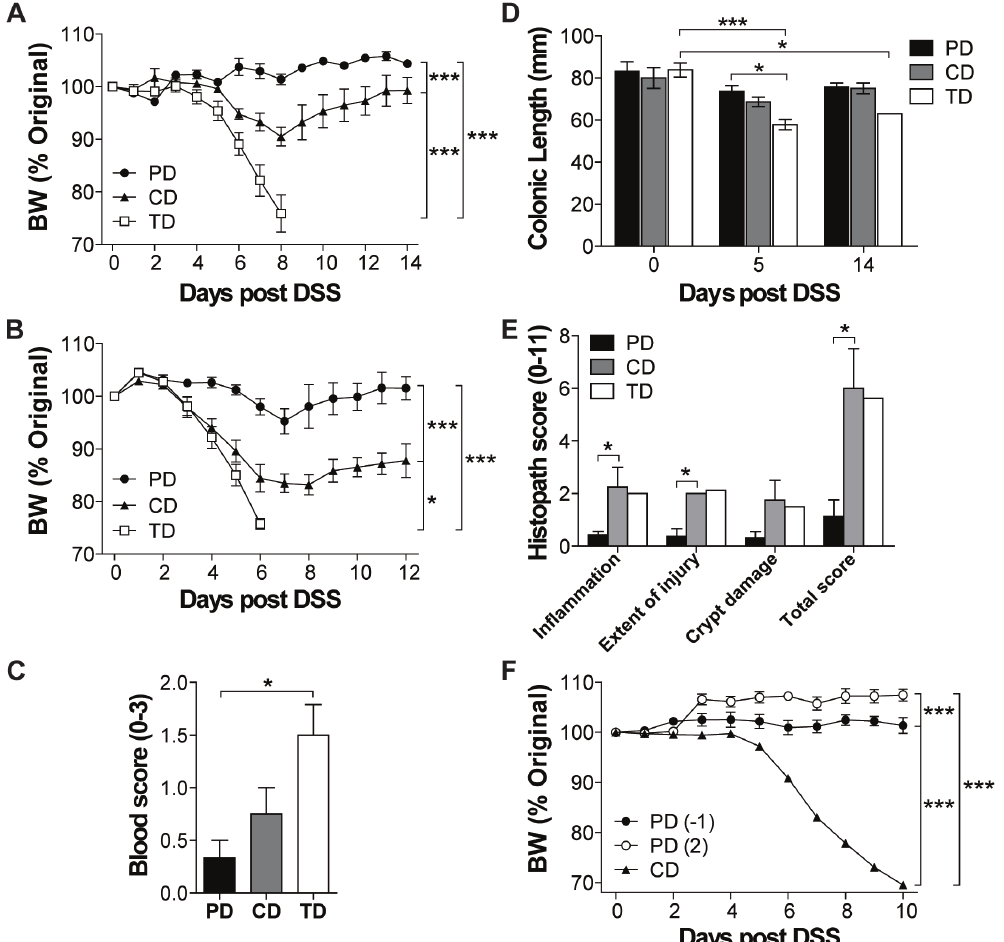
Figure 1. Diet induced changes in the susceptibility to DSS. WT or Rag KO mice were fed the experimental diets for 2 wks prior to 2.5% DSS treatment and throughout the experiment. Percent original BW of (A) WT (n=4–6 mice/group) and (B) Rag KO mice following the start of DSS treatment (n=3–5 mice/group). All three dietary groups were significantly different from each other (*P , 0.05, ***P , 0.001, two-way ANOVA). (C) Colonic blood scores in WT mice at d5 post DSS (n=3 mice/group). TD was significantly different from PD (*P , 0.05, one-way ANOVA with Tukey’s post-tests). (D) Colonic lengths of the WT mice at d0 (n=4 mice/group), d5 (n=3 mice/group), and d14 (n=4 mice/group except for TD n=1 mouse) following the start of DSS treatment. There was a significant effect of DSS treatment over time and between diet groups as indicated (*P , 0.05, two- way ANOVA with Bonferroni post-tests). (E) Histological scores of the distal colon of WT mice at d14 post DSS (n=2–4 mice per group except for TD n=1 mouse). CD was significantly different from PD (*P , 0.05, one-way ANOVA with Tukey’s post-tests). (F) BW change in mice fed CD, or PD the day before ( 2 1) or 2d after (2) DSS treatment was initiated (n=4–6 mice per group). All three dietary treatments were significantly different from each other (***P , 0.001, two-way ANOVA). Data shown are the mean + / 2 SEM from one representative of three independent experiments. BW, body weight; CD, chow diet; DSS, dextran sodium sulfate; KO, knockout; PD, purified diet; Rag, recombinase-activating gene; TD, Teklad diet; WT, wild-type.